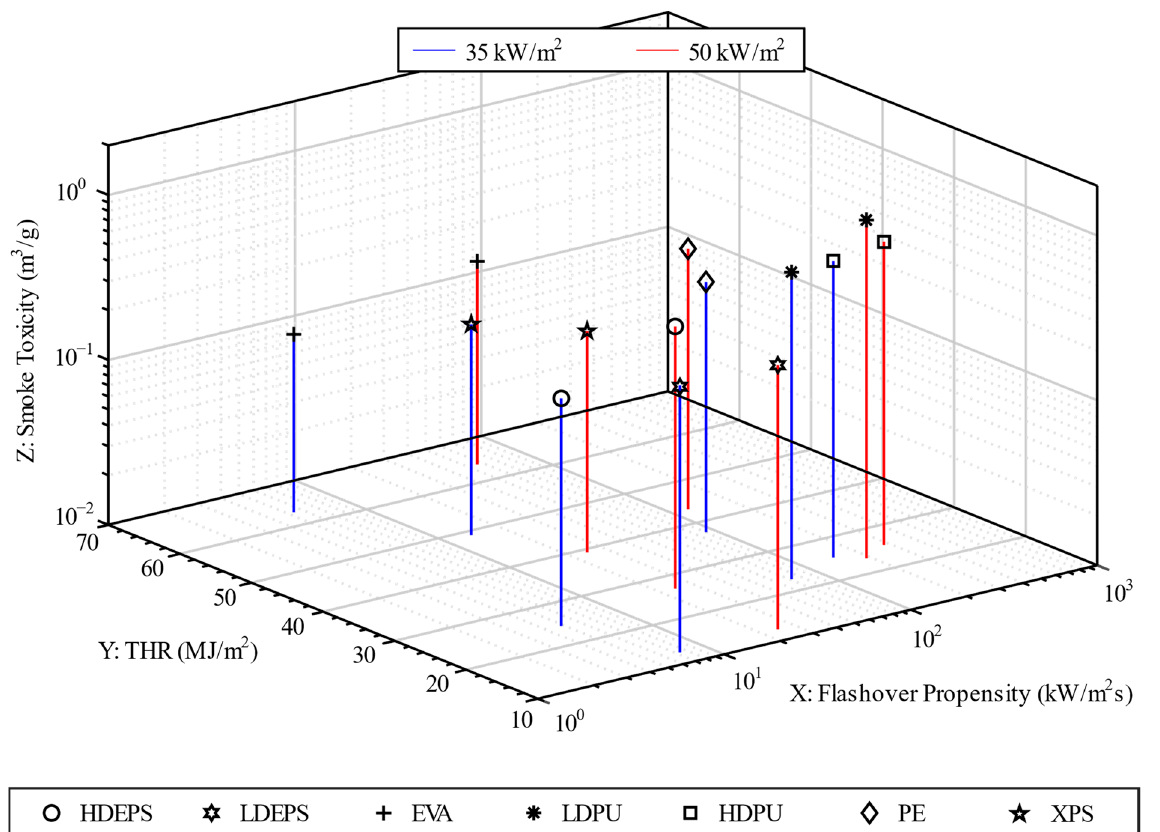
Figure 9. Risk diagram profile of polymer samples combusted at 35 kW/m 2 and 50 kW/m 2 heat fluxes.